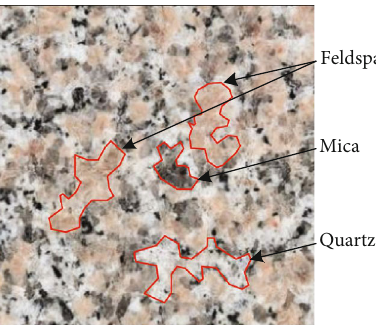
Figure 2: Actual granite